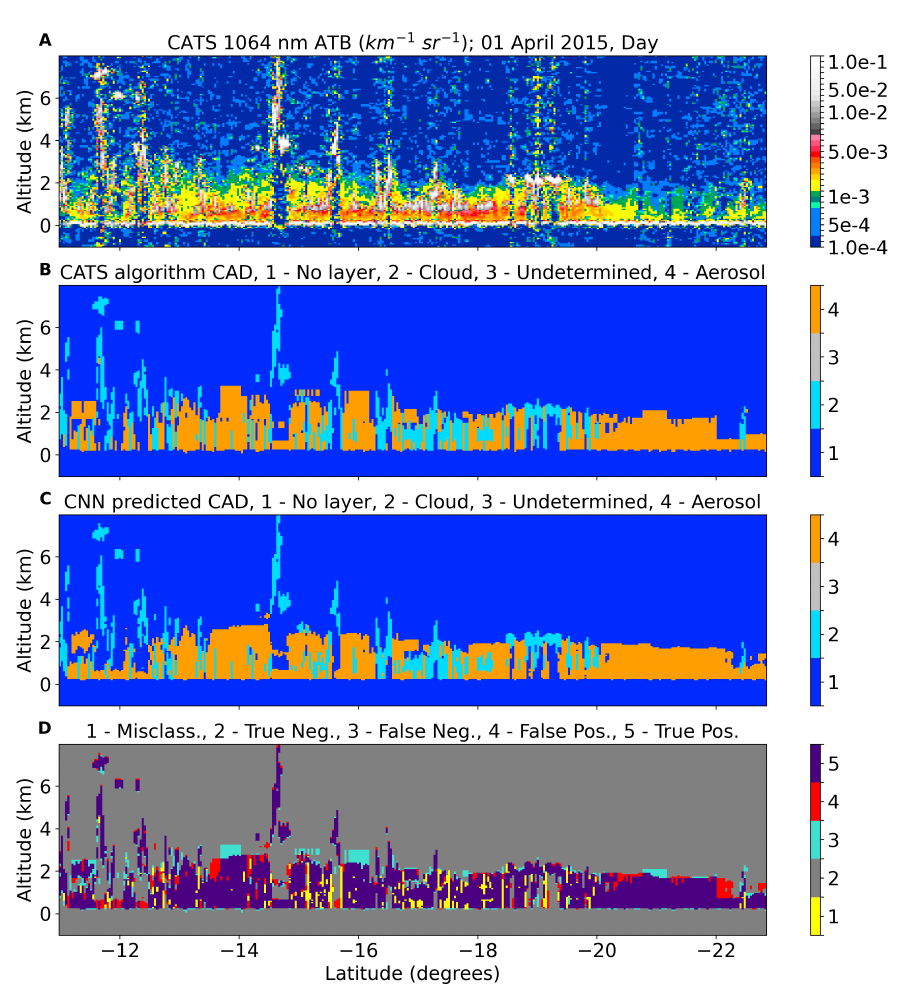
Figure 10. The same four plots and example as Figure 9. Images are focused on the PBL region. While the CNN technique presented here demonstrates improvements in layer de- tection at finer resolution and cloud-aerosol discrimination during daytime, this new ML technique also has limitations. At nighttime, the CNN technique only exhibits minor improvements to layer detection and CAD and, in some cases, actually performs worse than the operational CATS CAD algorithm. Figure 11 shows a nighttime case on 1 April 2015 with weakly scattering aerosol plumes lofted into the free troposphere in the same altitude regions as cirrus clouds. The aerosol plume between 1 ◦ S and 3 ◦ N latitudes is so optically thin (AOD of 0.02) that the CNN technique does not detect the feature at the 5 km horizontal resolution, whereas the operational CATS layer detection algorithm is sensitive to this layer at the 60 km horizontal resolution (Figure 11D, teal). The CNN technique does detect features with weak backscatter intensities (like lofted aerosols) around 7 ◦ N latitude adjacent to cirrus clouds with strong backscatter intensities (Figure 11C), but it classifies these optically thin features as clouds when the operational CATS CAD algorithm classifies them as aerosols (Figure 11D, yellow). Since the CNN model is based on the statistical significance of the features in the training dataset, and free tropospheric aerosol layers are far less frequent in the CATS training dataset compared to cirrus clouds, the CNN misclas- sifies these layers as clouds. Thus, training datasets must be carefully selected to optimize performance of the CNN technique. Further experiments are needed to assess the amount of samples needed for specific atmospheric features to overcome these